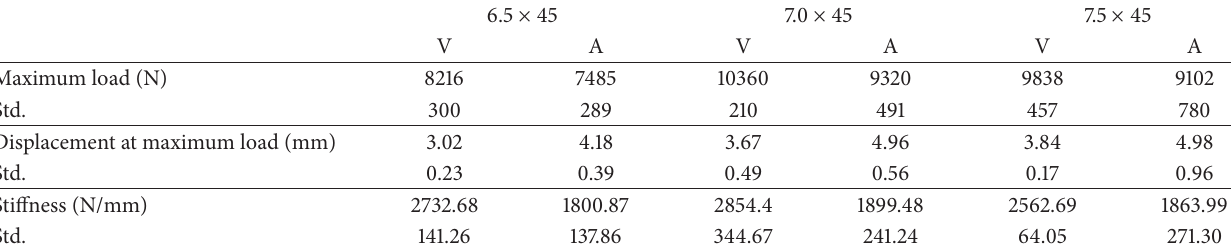
Table 1: Axial pullout test